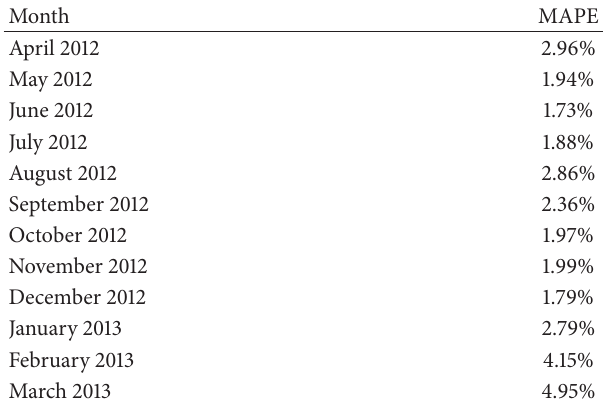
Table3:Inthefirstcolumn,wehavethemonthsofelectricitysupply of the peak contracts considered, while in the second column we have the mean absolute percentage errors obtained in the long-term forecasts of the contracts